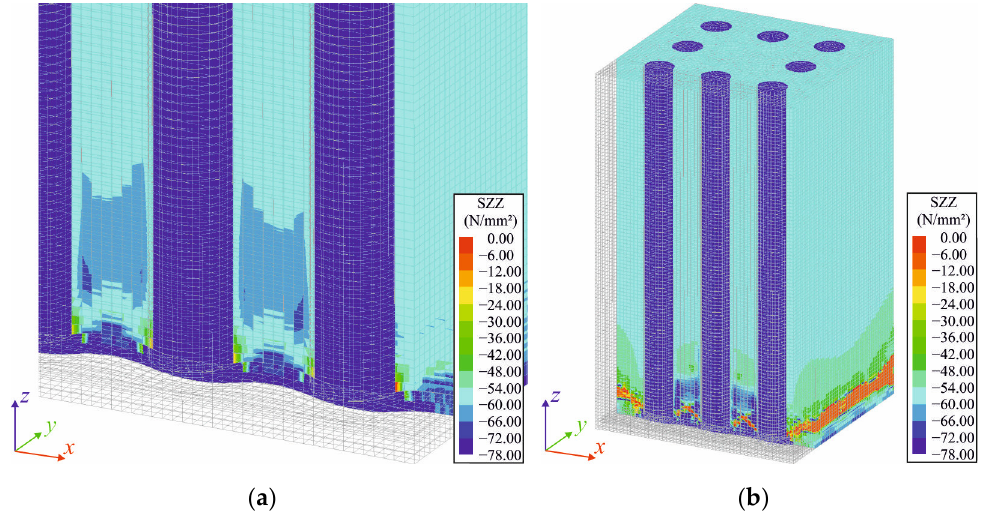
Figure 18. Contour plot of compressive stresses: ( a ) detail of rebars deforming the steel plate at 90% of ultimate load; ( b ) compressive concrete stresses at ultimate load.